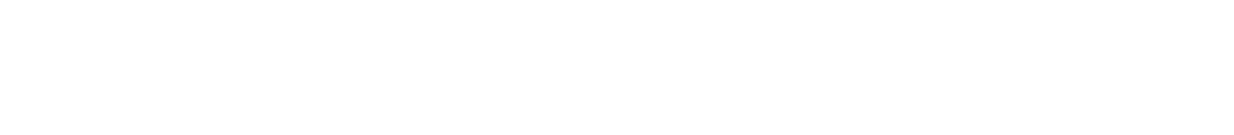
FIGURE7| QRKSGinterventiononNSrats. (A) PCAscorechart; (B) PLS-DAscorechart; (C) PCAanalysisofthemodelandQRKSGgroups; (D) PLS-DAanalysis of the model and QRKSG groups; (E) Heatmap visualization of the 24 potential metabolites expressed in rat kidneys; (F) MetaboAnalyst5.0 pathway analysis.